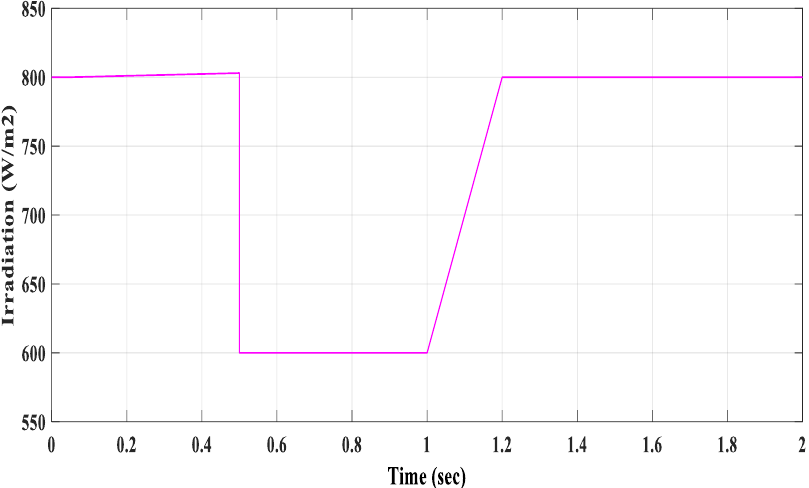
Figure 19. Irradiation pattern of input for PV system.